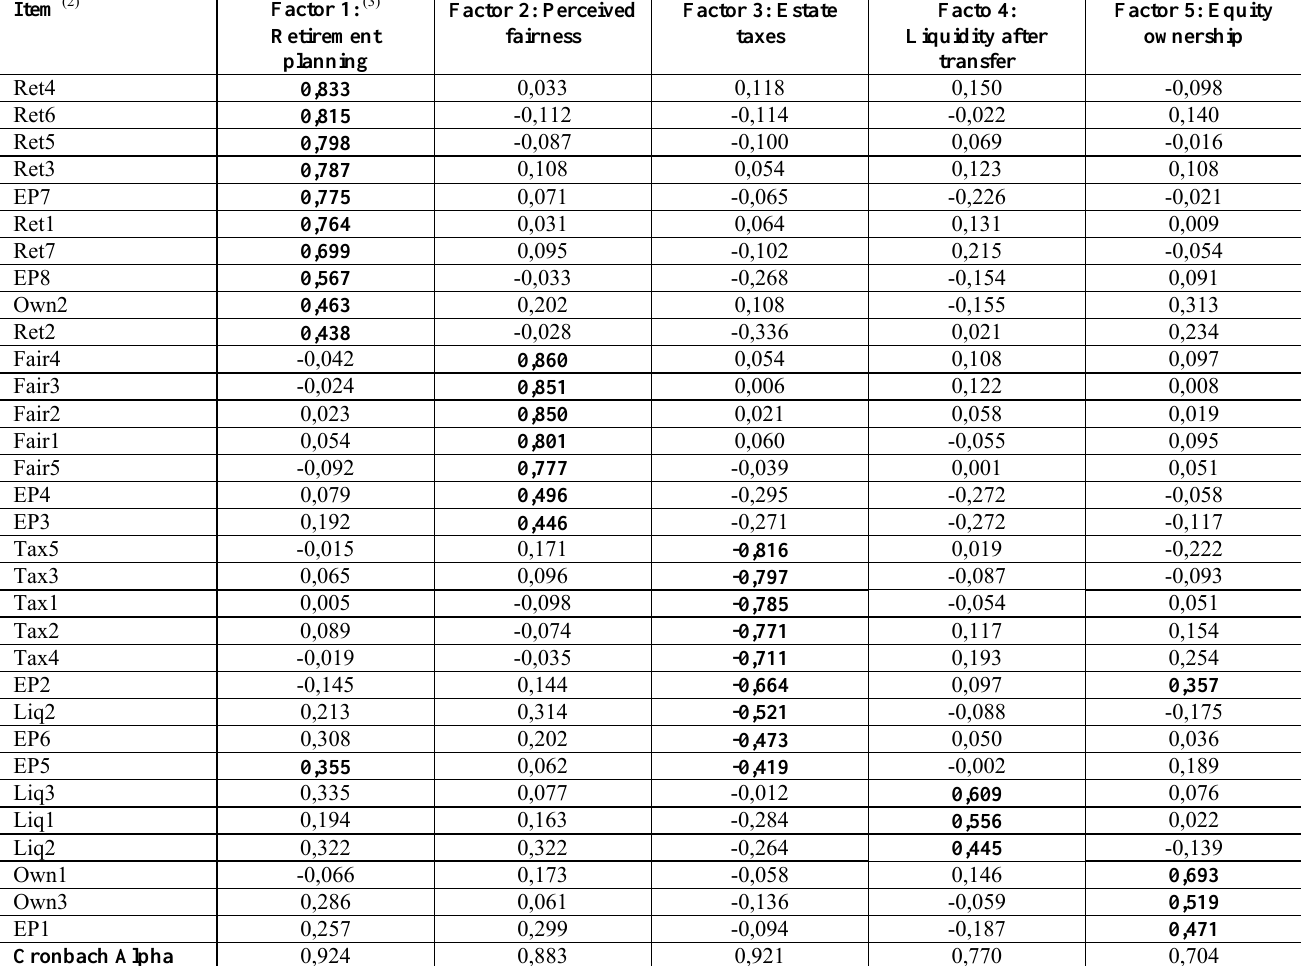
Table 1: Pattern matrix of Oblimin rotated-principal component factor analysis